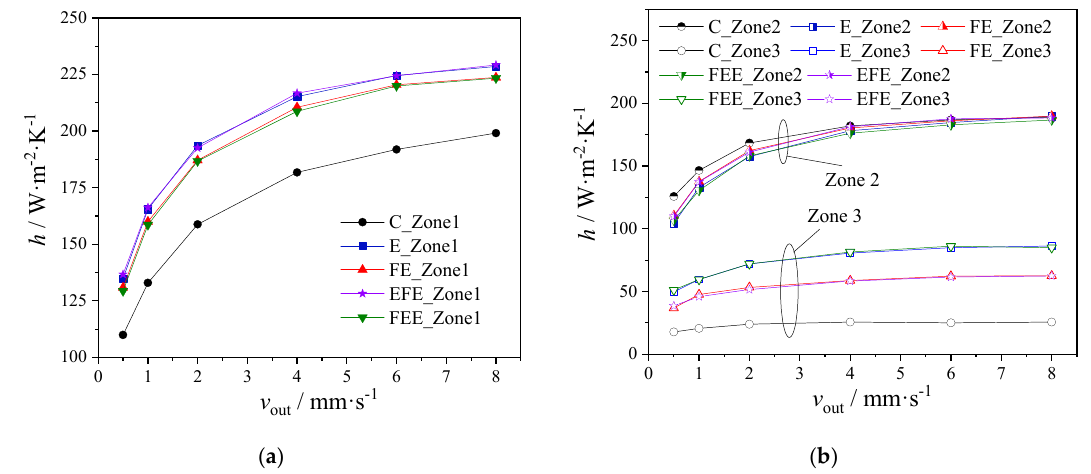
Figure 9. Variations of local heat transfer coefficients of particle flow with v out for different tubes ( d p = 1.72 mm): ( a ) Zone 1; ( b ) Zone 2 and Zone 3.